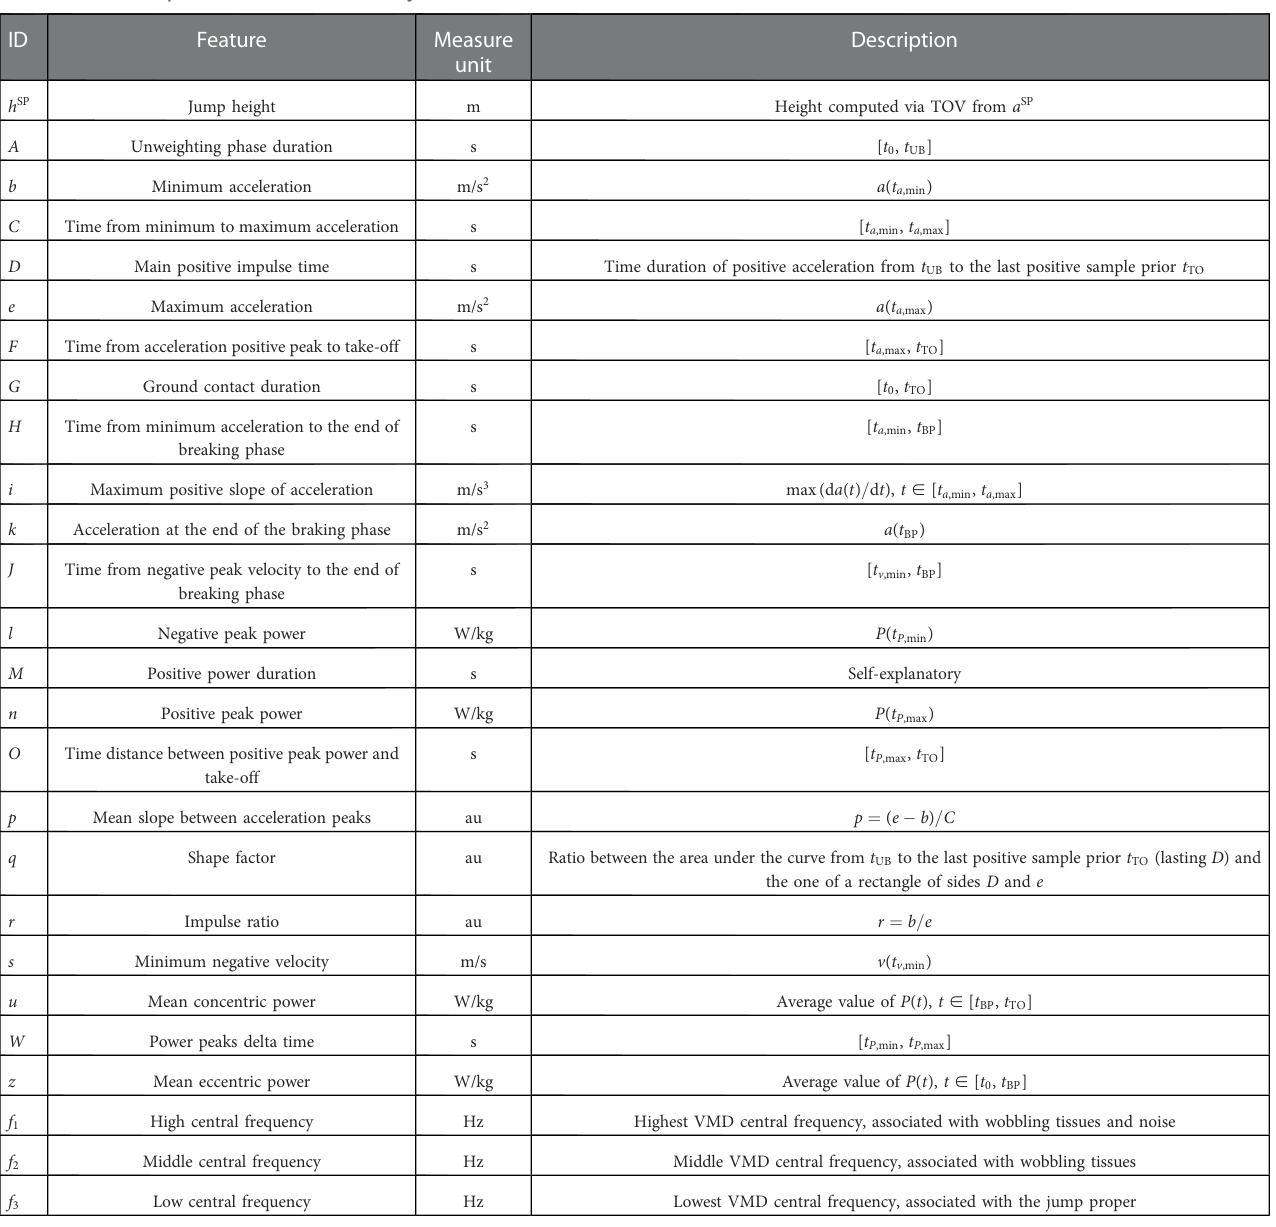
TABLE 1 Detailed explanation of each of the analyzed features.